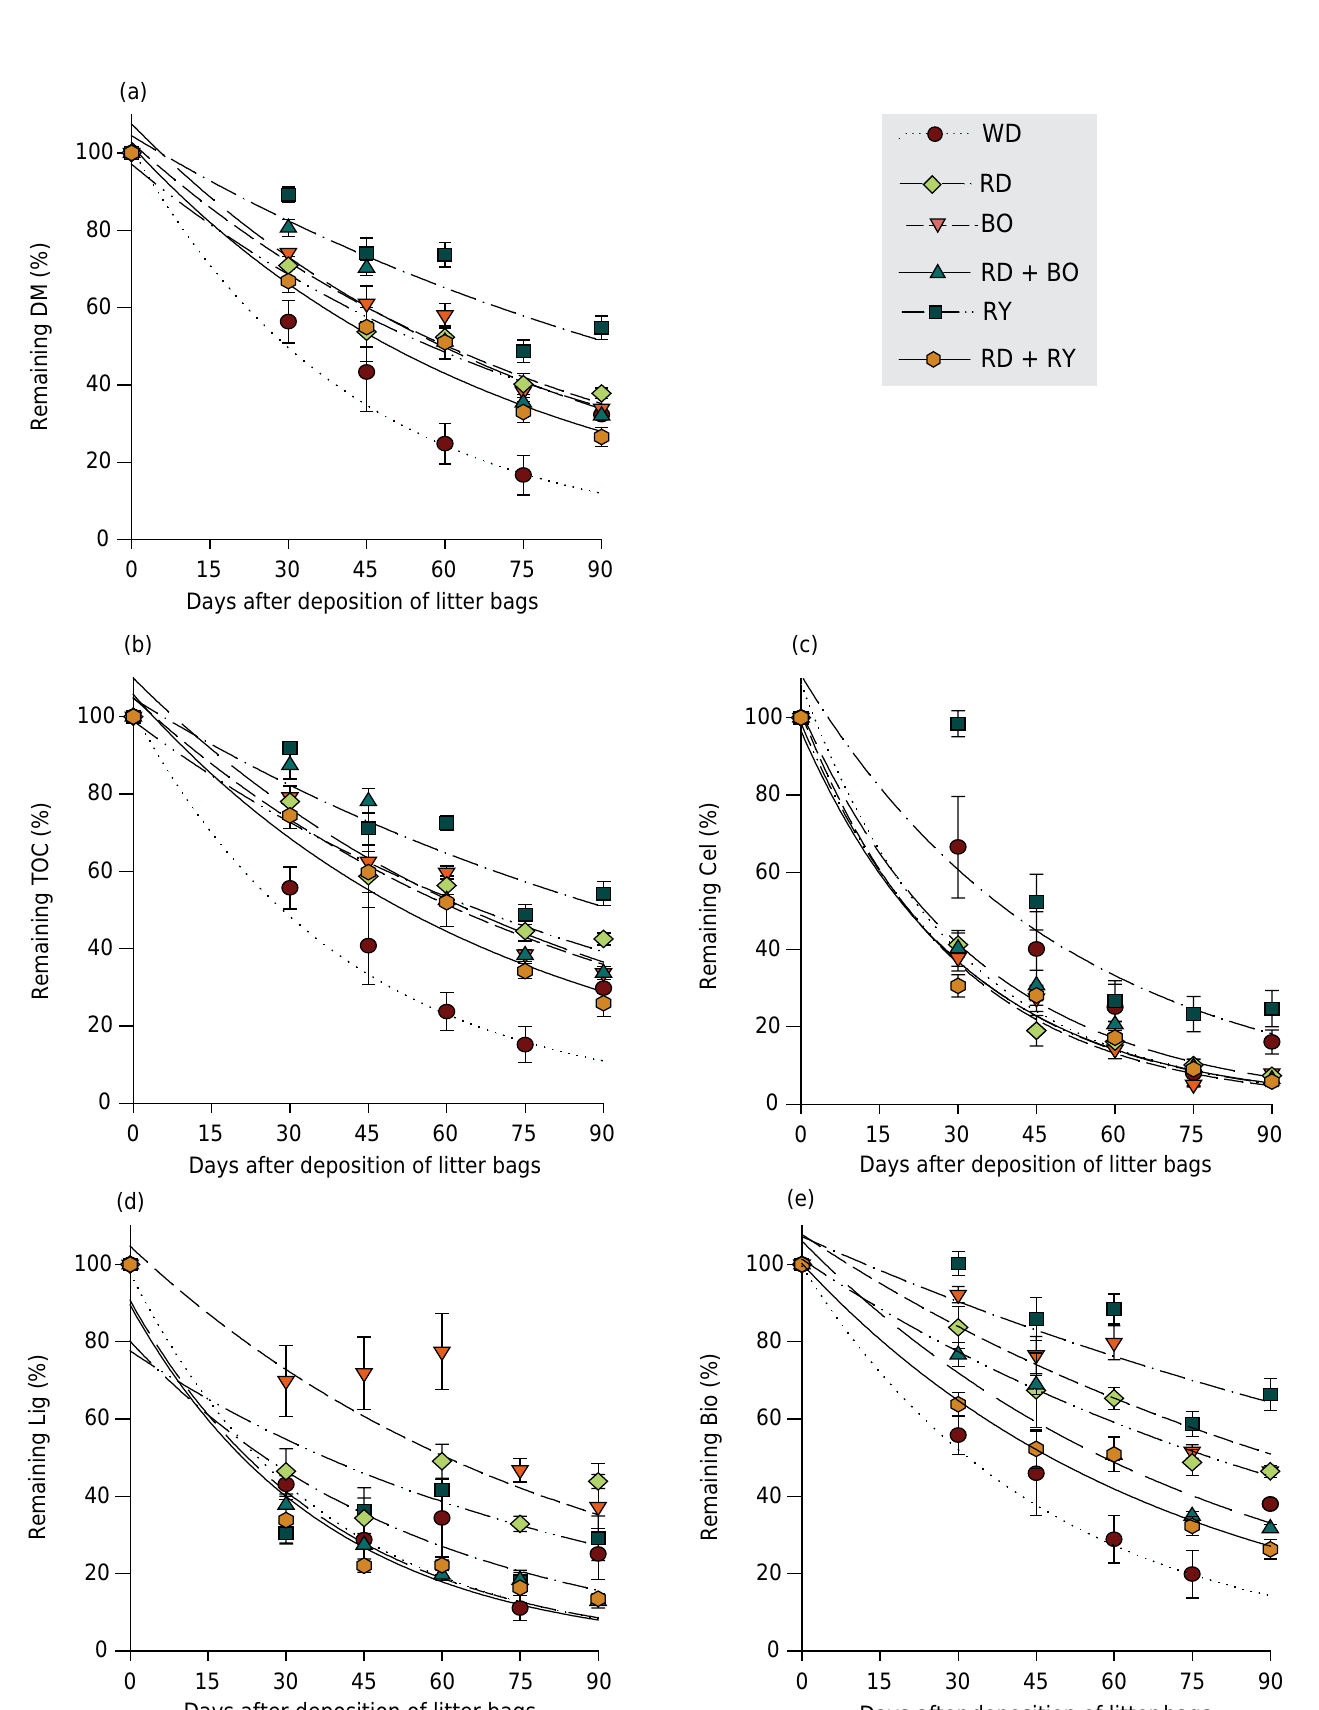
Figure 2. Remaining percentage of dry matter (DM) (a), total organic carbon (TOC) (b), cellulose (Cel) (c), lignin (Lig) (d), and non-structural biomass (Bio) (e) in the residues of weeds (WD), black oat (BO), rye (RY), oilseed radish (RD), oilseed radish + black oat (RD + BO), and oilseed radish + rye (RD + RY) deposited on the onion row for a period of 90 days. Vertical bars represent standard error of the